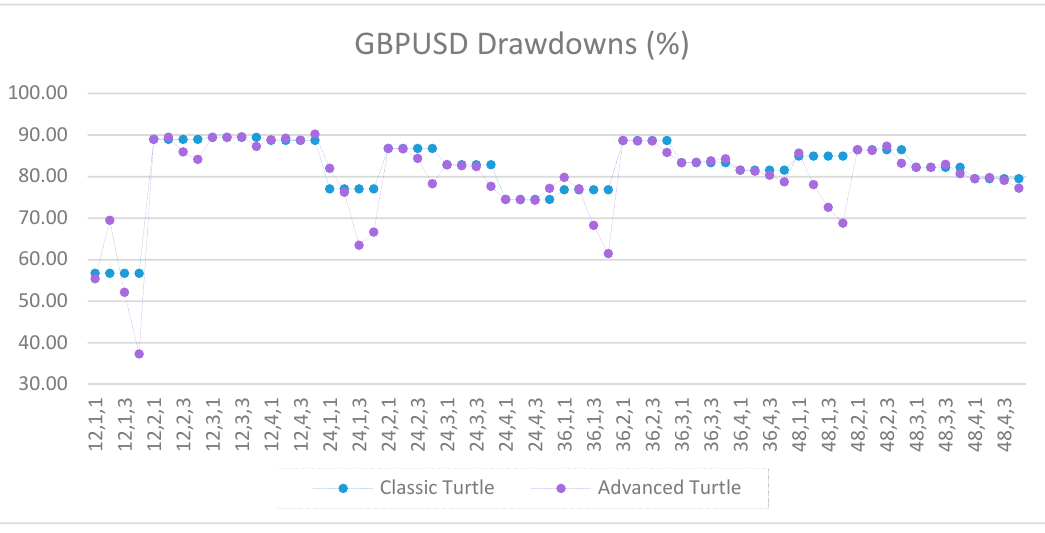
Figure A38. Drawdowns of GBPUSD as percentage of equity between the classic and the advanced Turtle systems for every combination of N, X, Y for the slow parameters (80, 160).